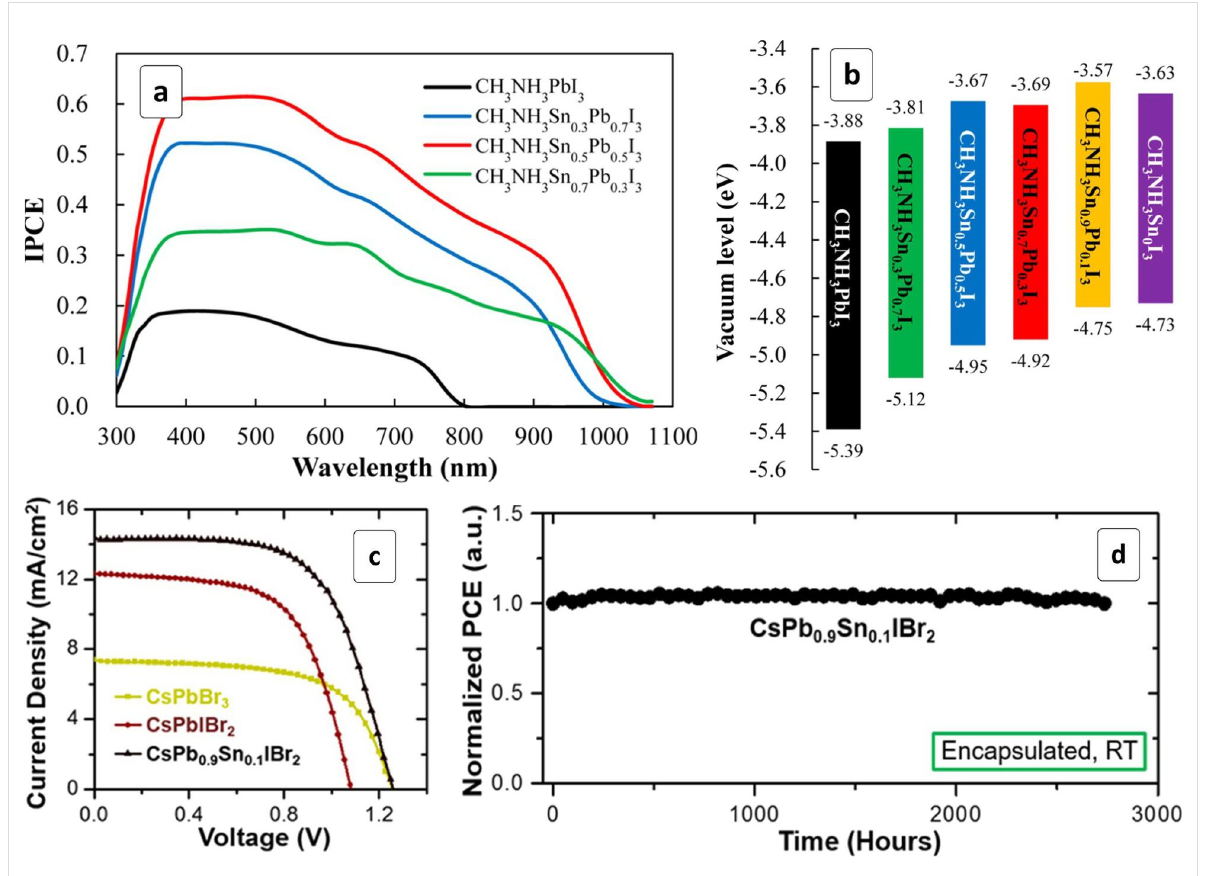
Figure 3: (a,b) Internal photon-to-current conversion efficiency (IPCE) spectra of solar cells comprising a series of Sn,Pb-based HPs with different Sn/Pb ratios (a) and energy diagram of the corresponding perovskites (b); (c) current–voltage curves for solar cells based on CsPbBr 3 , CsPbIBr 2 and CsPb 0.9 Sn 0.1 IBr 2 HPs; (d) test of prolonged performance stability of a solar cell based on CsPb 0.9 Sn 0.1 IBr 2 HP, RT – room temperature. (a,b) Reprinted with permission from [68], copyright 2014 American Chemical Society and (c,d) Reprinted with permission from [69], copyright 2017 American Chemical